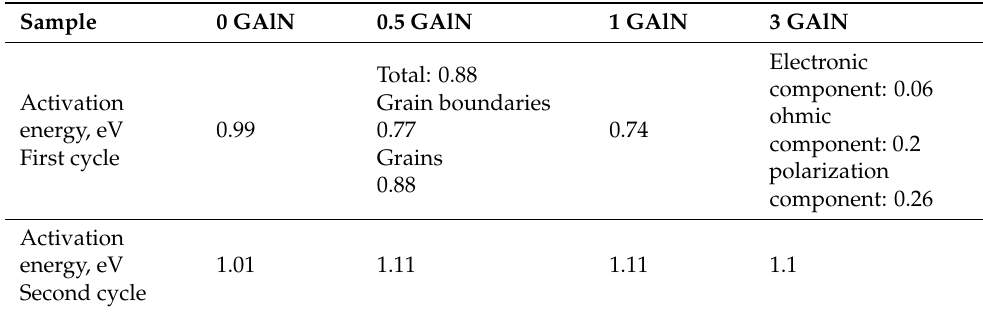
Table 3. Activation energies, calculated from Arrhenius plots for 0 GAlN–3 GAlN composites. No data were obtained for 5 GAlN due to the absence of the linear